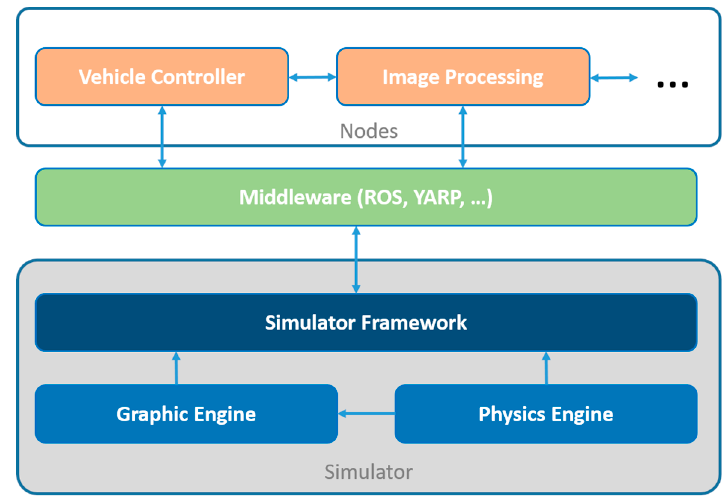
Figure 8. Typical software architecture of a simulator.